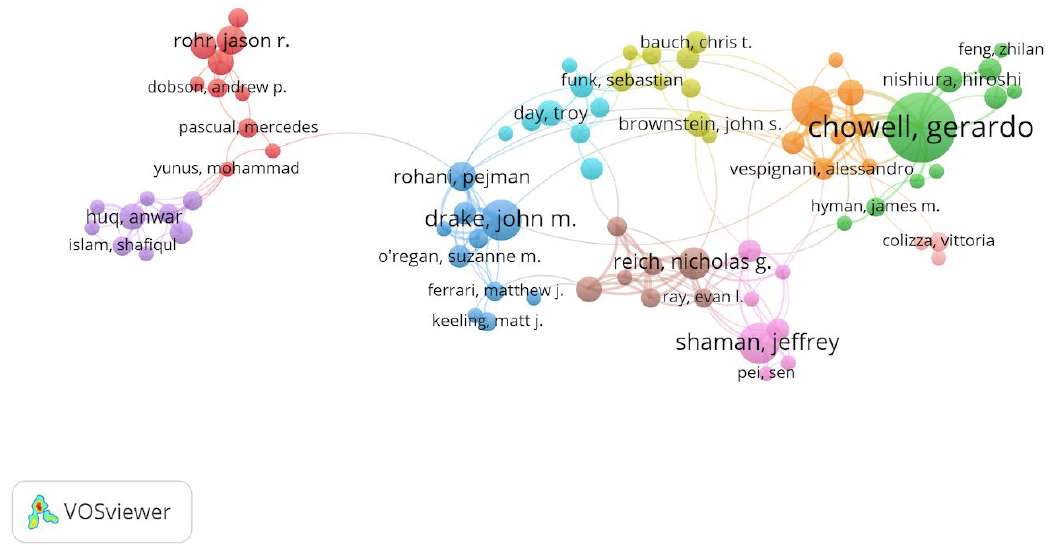
Figure 4. Collaborative network of co-authors in the field of prediction of infectious diseases.